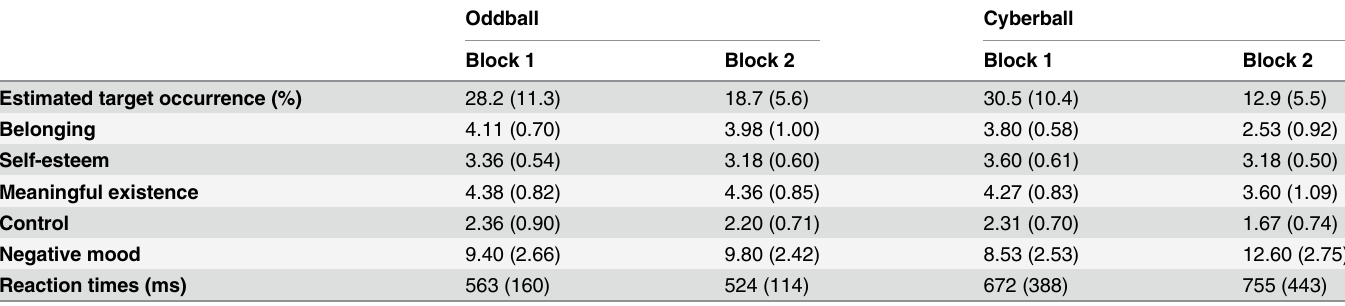
Table 1. Questionnaire and behavioral data of the Oddball and Cyberball group for the two experimental